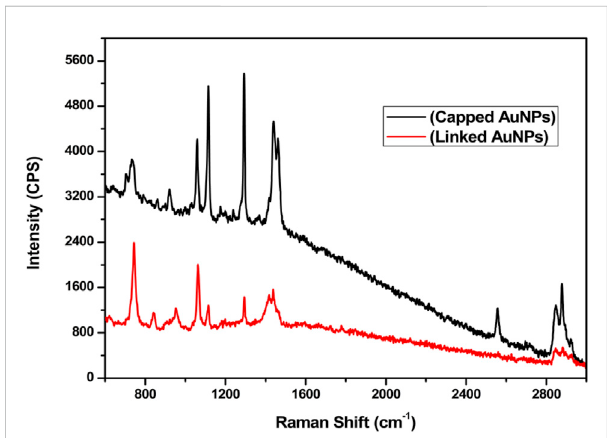
FIGURE 5 Raman spectroscopy (SERS) showing spectra of chemical bond stretching for C – H, S – H, C – H, N=N, C – O – C, C – C, and C – S at corresponding peaks of 2,845, 2,878, 2,556, 1,463, 1,440, 1,292, 1,114, 1,058, 921, 736, and 705 cm − 1 for capped AuNPs and stretching vibrations of C – H, C=O, N=N, C – C, C – O – C, and C – S at enhanced peaks of 2,843, 1,723, 1,425, 1,294, 1,112.94, 1,063, and 744 cm − 1 for linked AuNPs,